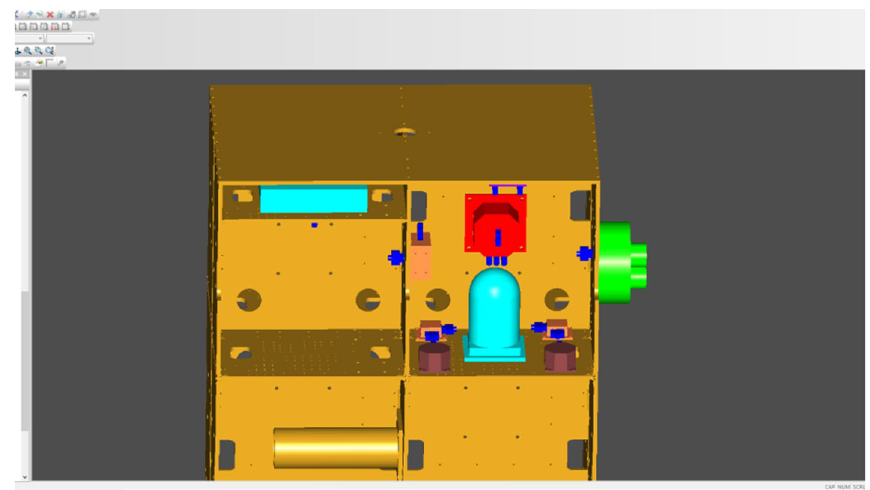
Figure 15. Digital prototype of the satellite simulator in our wiring